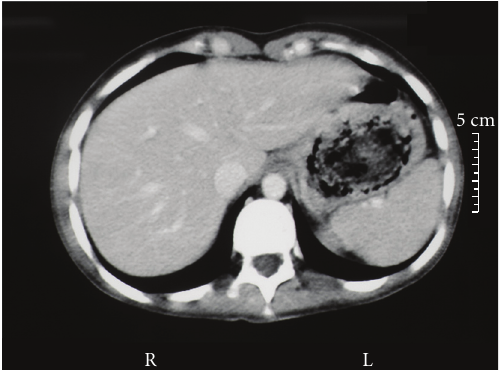
Figure 3: Tomography image of a trichobezoar in the stomach.